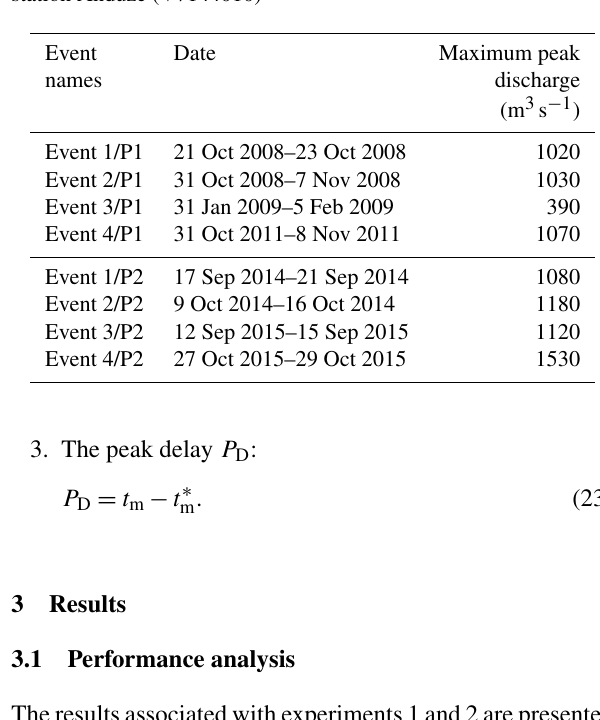
Table 2. Selection of major floods for each period P 1 and P 2 at station Anduze